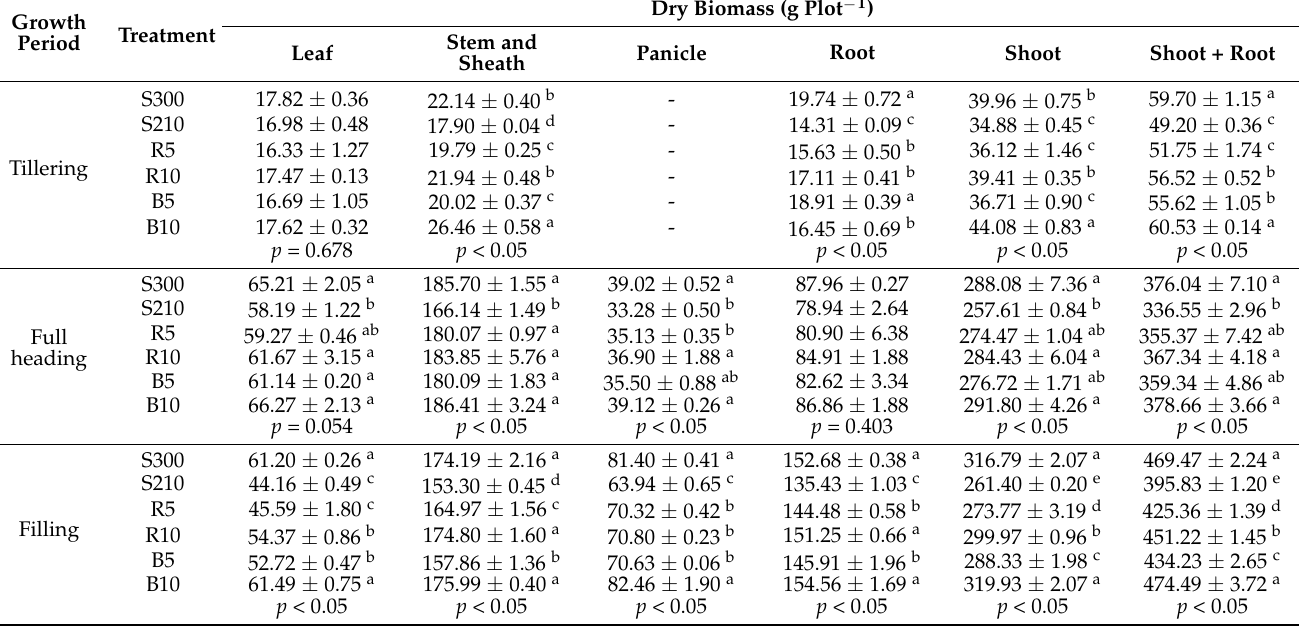
Table 2. Dry biomass of medium rice at different growth stages under different fertilization